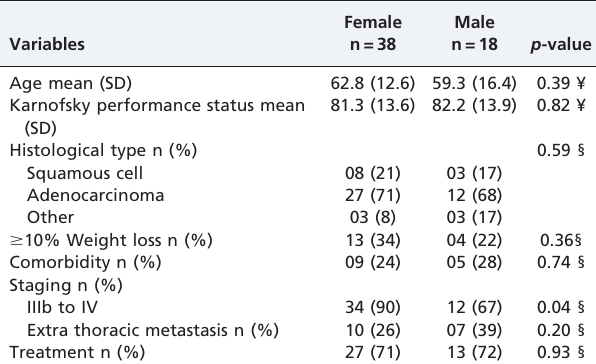
Table 2 - Subject characteristics of never-smoker patients by gender.